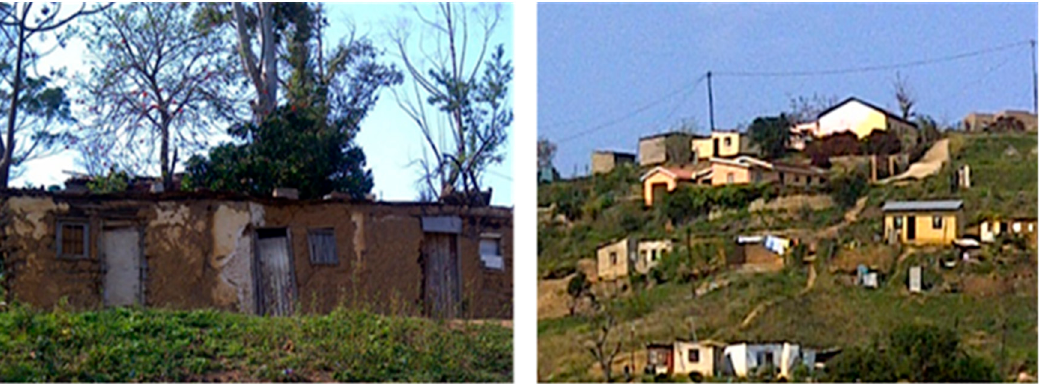
Figure 3. Types of houses in the rural settlement.